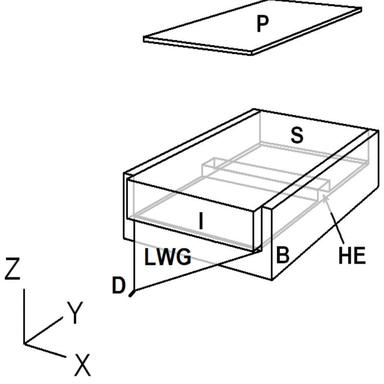
Schematic of the rectangular target plate three-dimensional buried charge setup.